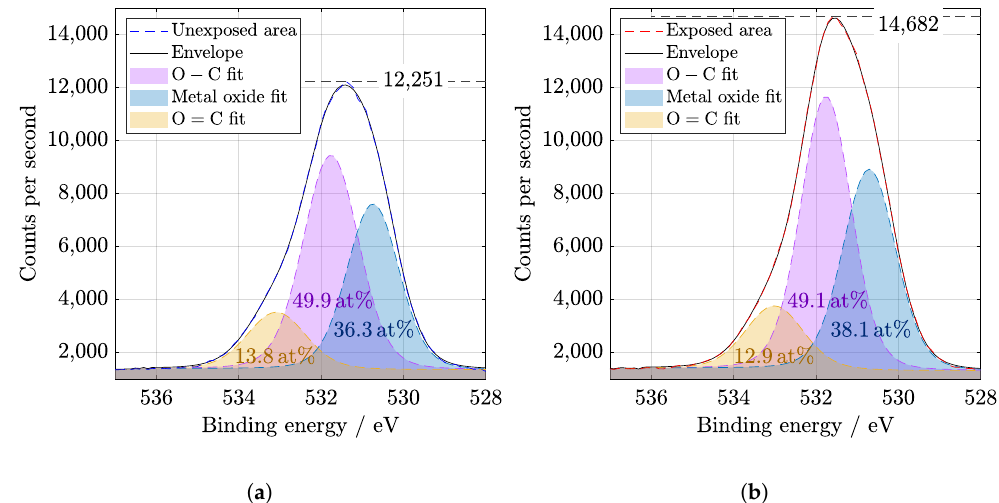
Figure 7. High resolution of O1s region from XPS ( a ) before and ( b ) after SL irradiation of 67 days. Binding energy value for O − C is 531.7 eV, for metal oxide is 530.7 eV, and for O = C is 533 eV. It can be seen there is an increase in the exposed area, compared to the C1s region, where is a slight decrease.